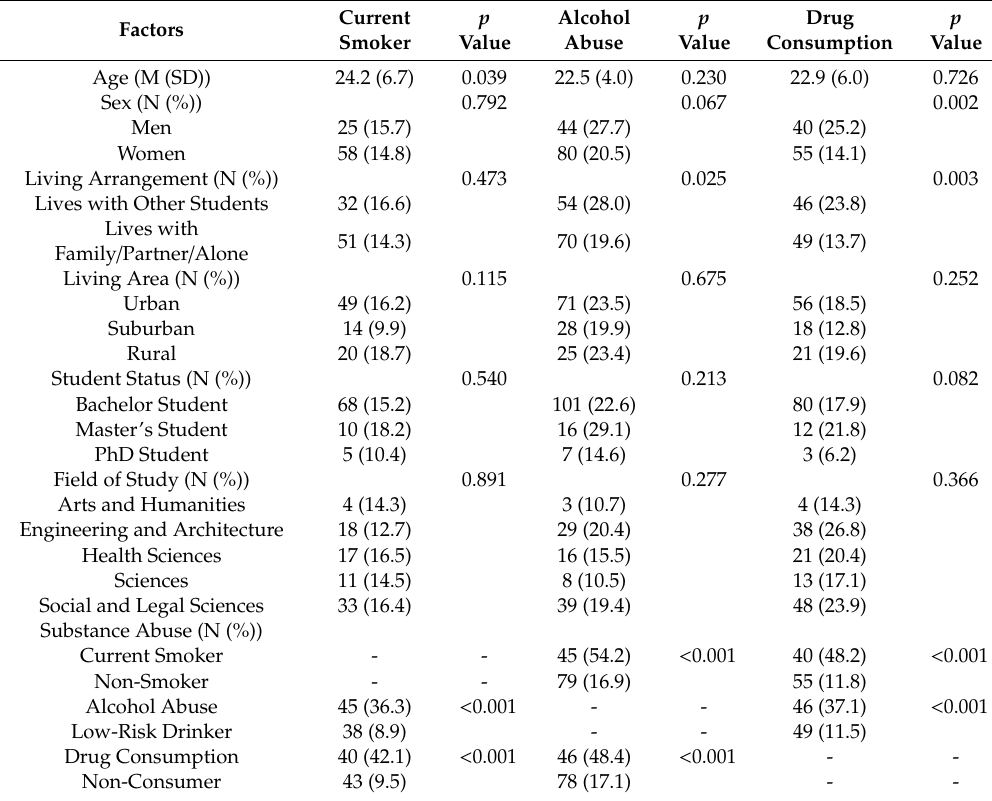
Table 3. Sociodemographic and environmental risk factors for substance abuse ( n = 550).